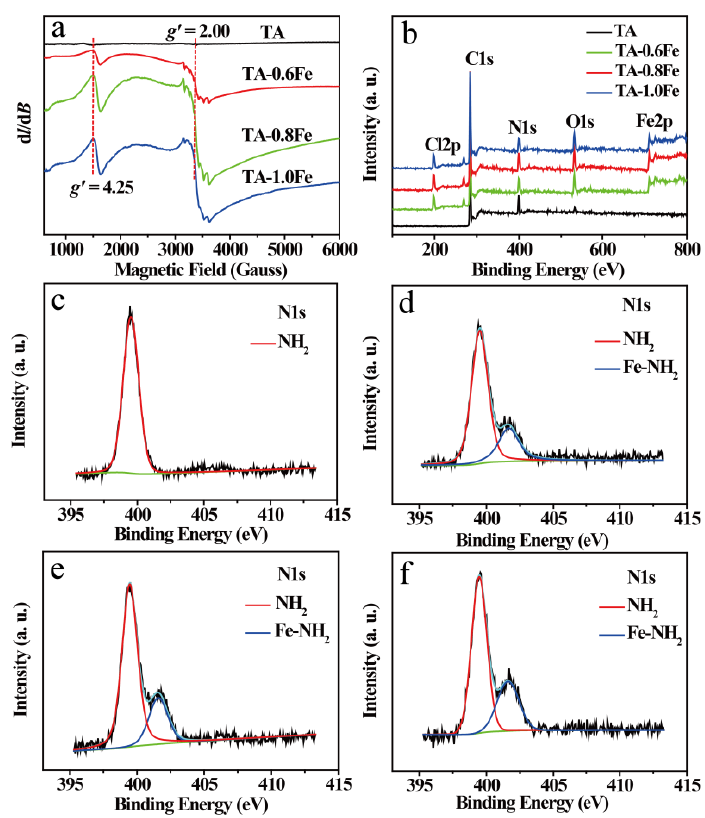
Figure 2. ( a ) EPR spectra of TA, TA – 0.6Fe, TA – 0.8Fe and TA – 1.0Fe. ( b ) XPS survey spectra of TA, TA –